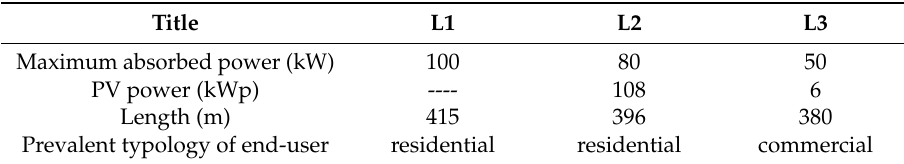
Table 1. Characteristics of the PDS under